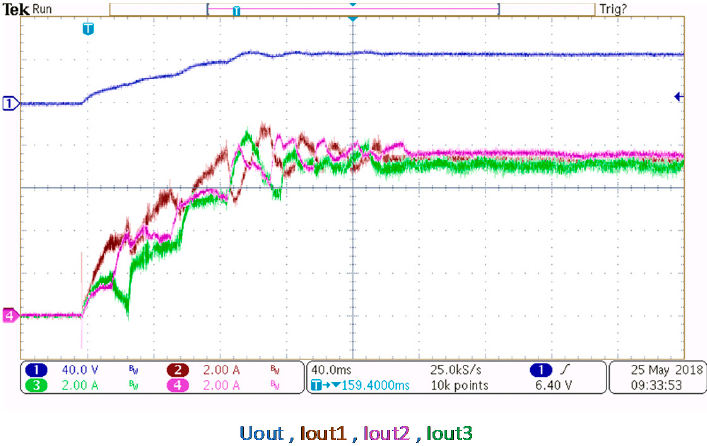
Figure 12 . MAPS start-up sequence for MASTER-voltage, SLAVE-current control strategy ( P OUT =